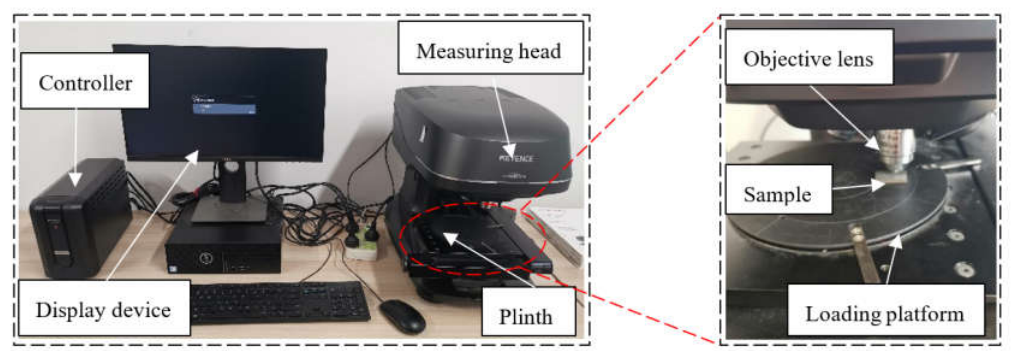
Figure 7. Thread sample to be measured.